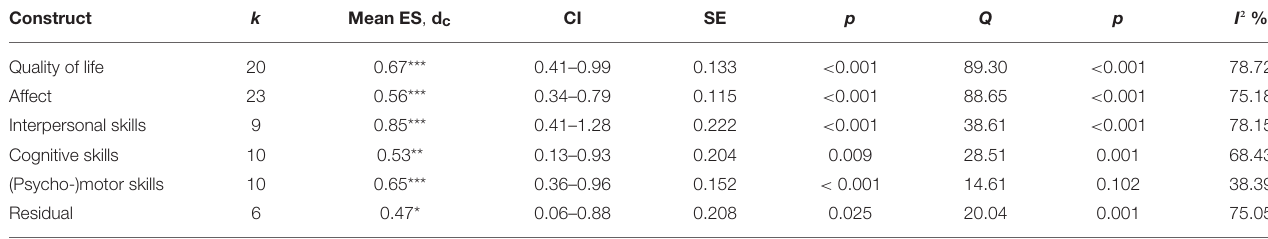
TABLE 2 | Effect sizes according to outcome cluster.